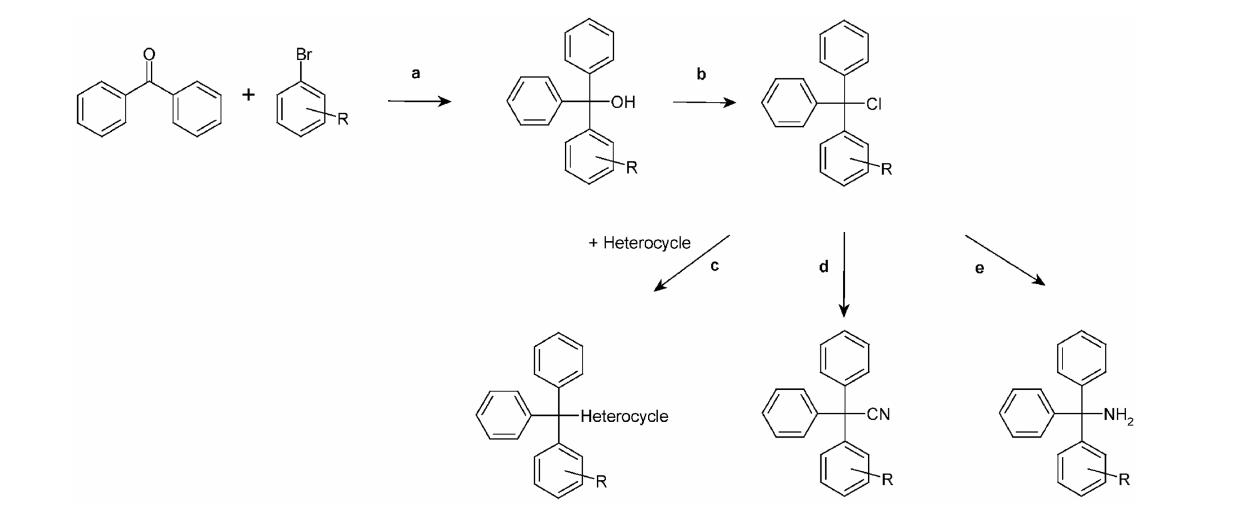
FIGURE 3 | Chemical synthesis scheme. a, Grignard reaction; b, CH3COCl; c, Excess of amine; d, CuCN; e,